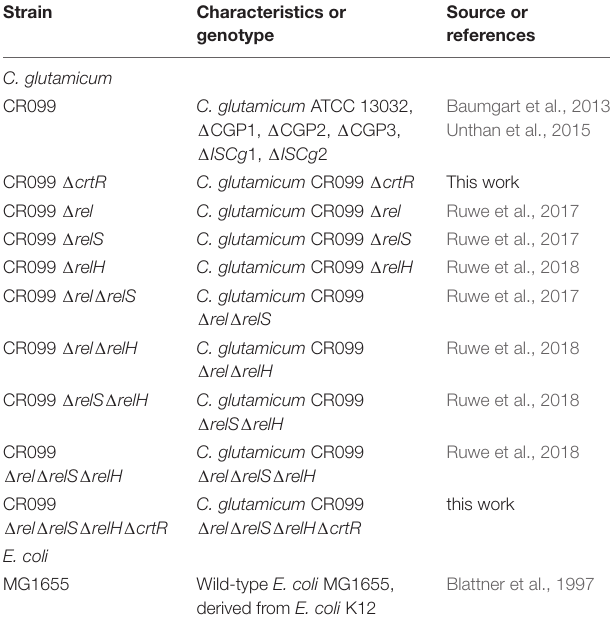
TABLE 1 | Bacterial strains used in this